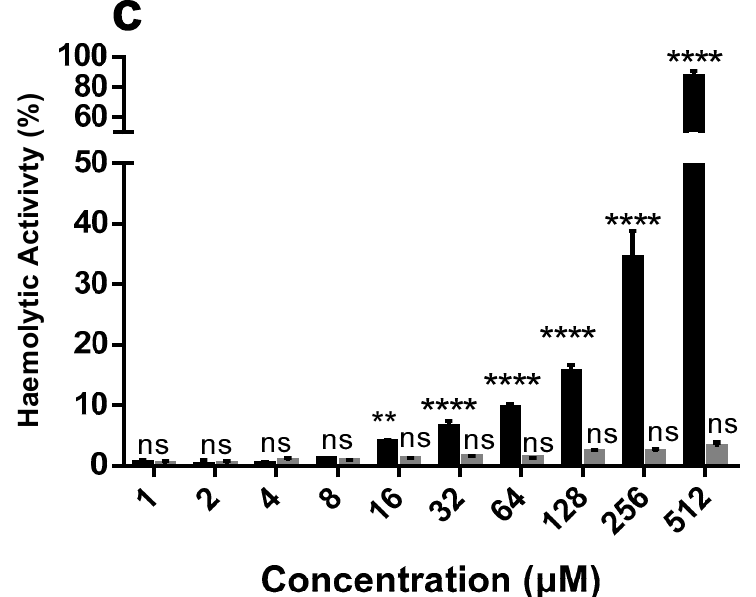
Figure 4. The cytotoxicity evaluation of DMPC-10A (black) and DMPC-10B (grey). ( a ) The cell viability of HaCat (human keratinocyte cell line) treated by DMPC-10A and DMPC-10B. ( b ) The release of lactate dehydrogenase (LDH) from HaCat cells in the presence of DMPC-10A and DMPC-10B. ( c ) The hemolytic activities of DMPC-10B and DMPC-10A at concentrations of 1 to 512 μ M. The percentage was calculated based on the effect induced by a positive control, 1% Triton X-100. Treatment with phosphate-buffered saline (PBS) was used as a negative control. Error bars indicate standard deviation (SD) of 15 replicates in three tests (5 replicates each time). The statistical significance was calculated using one-way ANOVA and is indicated as ns (nonsignificant difference), * ( p < 0.05), ** ( p < 0.01), and **** ( p < 0.0001).